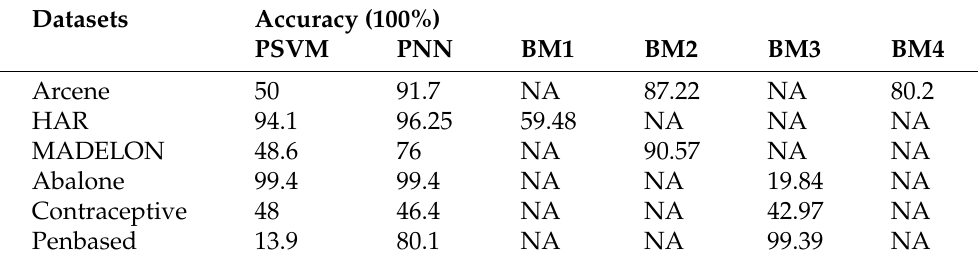
Table 11. Accuracy rates between proposed work and benchmark